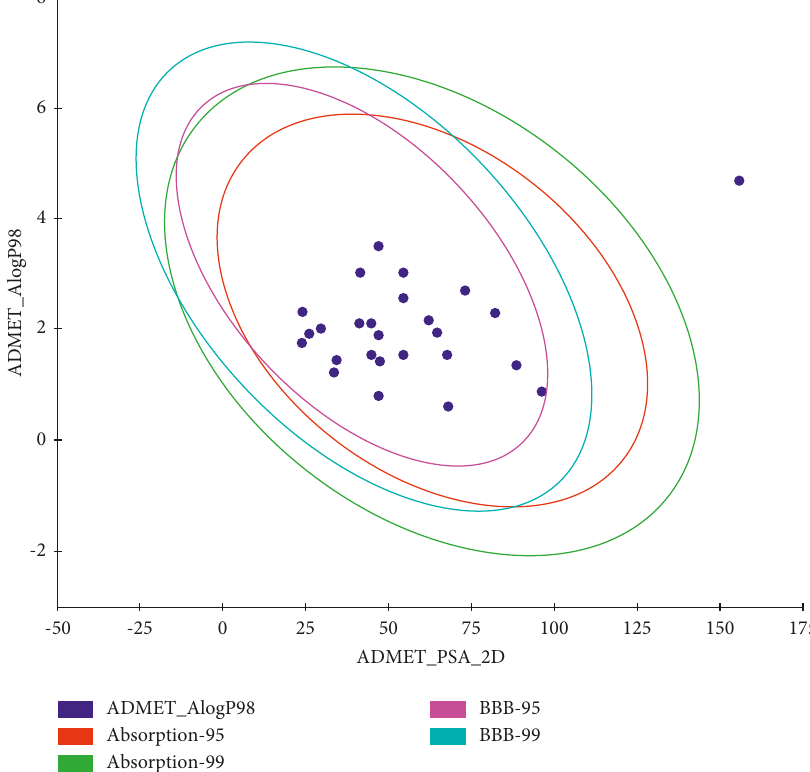
Figure 11: Results of the ADMET study.